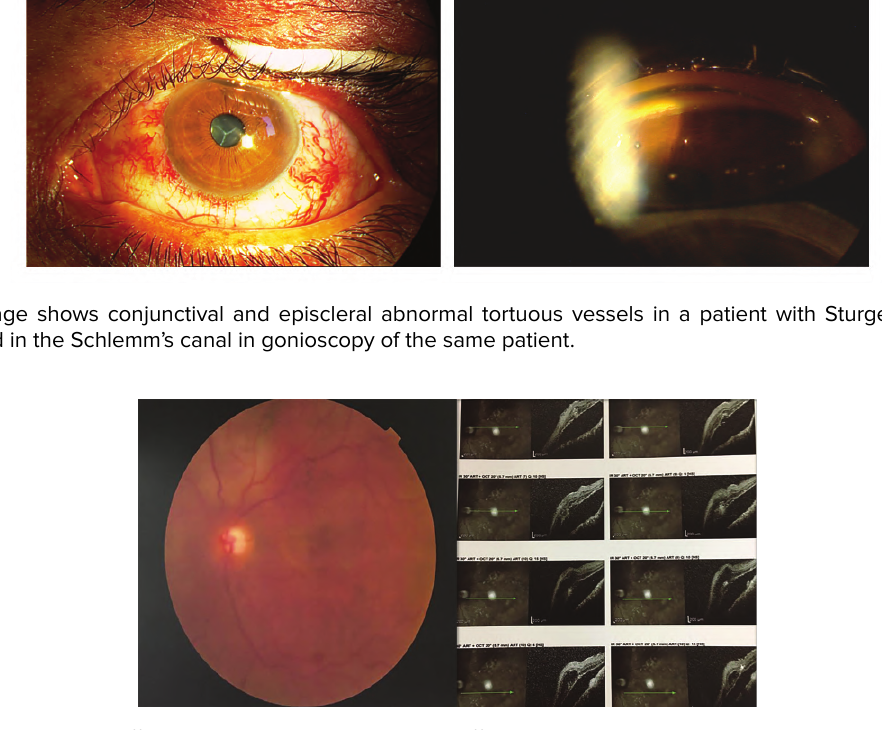
Figure 2. Left image shows diffuse choroidal hemangioma as diffuse dark and saturated red areas making “tomato-ketchup appearance” in the fundus of a patient with Sturge-Weber syndrome. Severe exudative retinal detachment is evident in optical coherence tomography images of the same